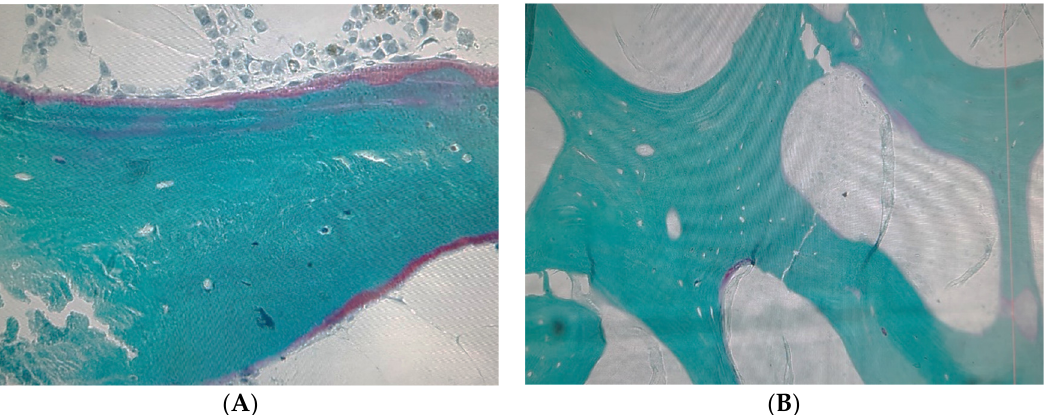
Figure 4. Bone biopsy. Baseline BB with Osteocytes ( A ) and FW BB with osteocytes lacunes ( B ). (Authors microscopy images 200×).